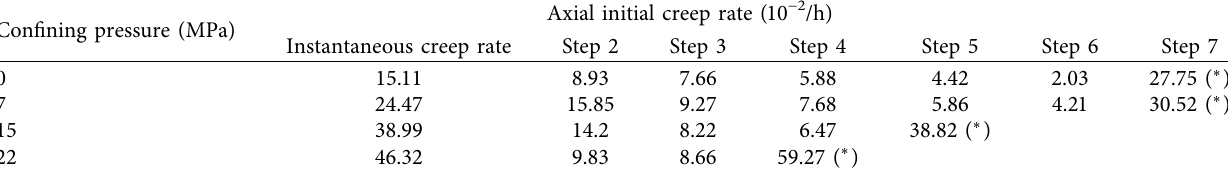
Table 5: Step loading initial creep rate of rock-concrete composite specimens under different confining pressures.